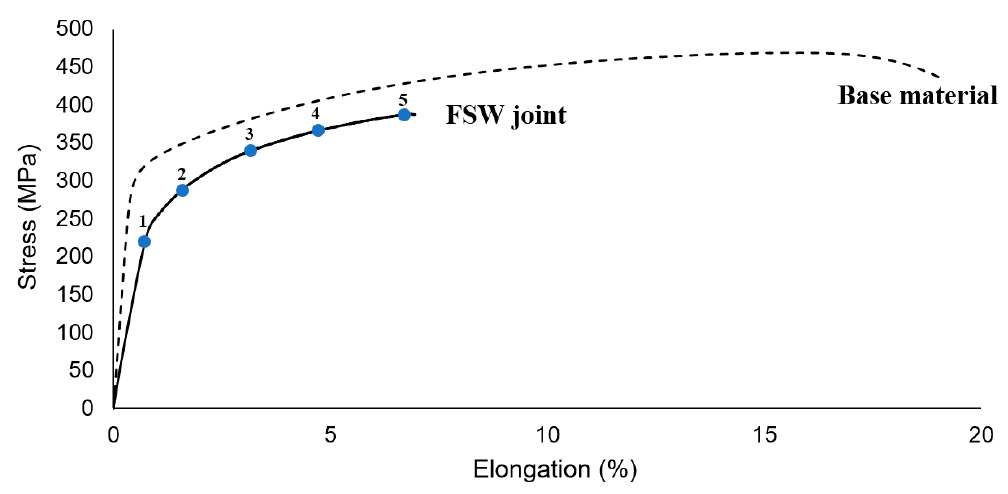
Figure 7. Engineering tensile stress–strain curves of base material and FSW joint.